Question: Looking at the figure, what chart type is it?
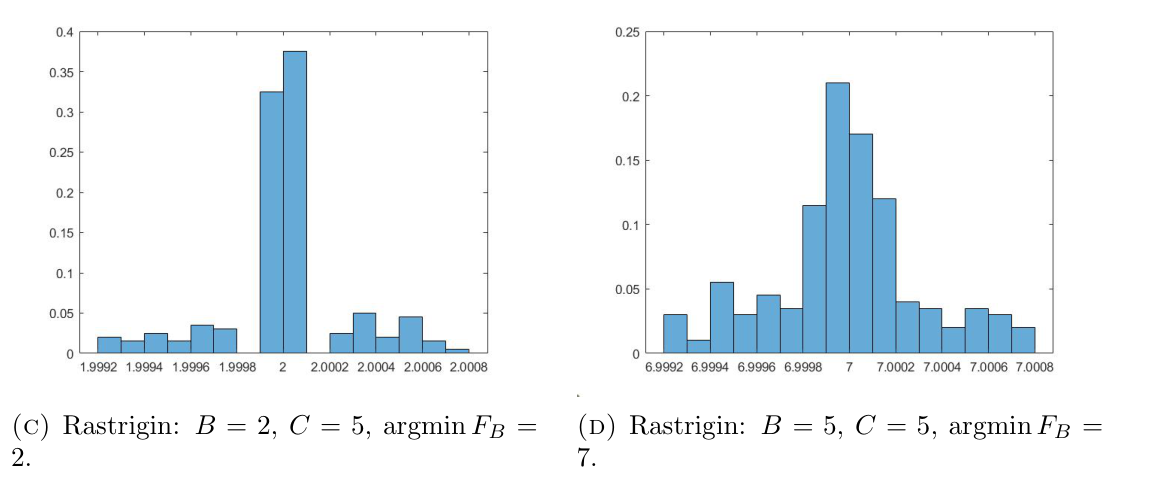
Answer: histogram